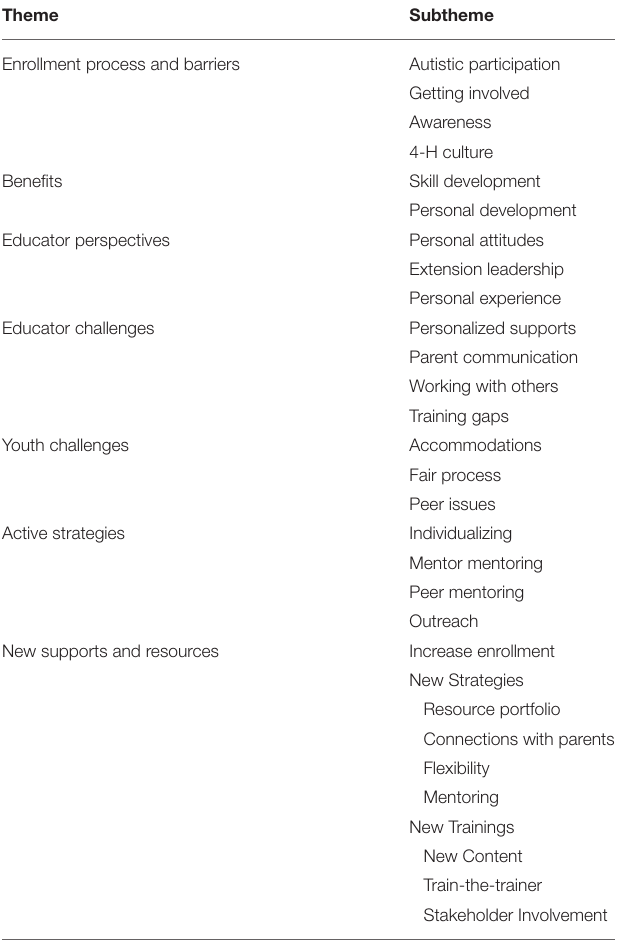
TABLE 2 | Results: Themes and subthemes.